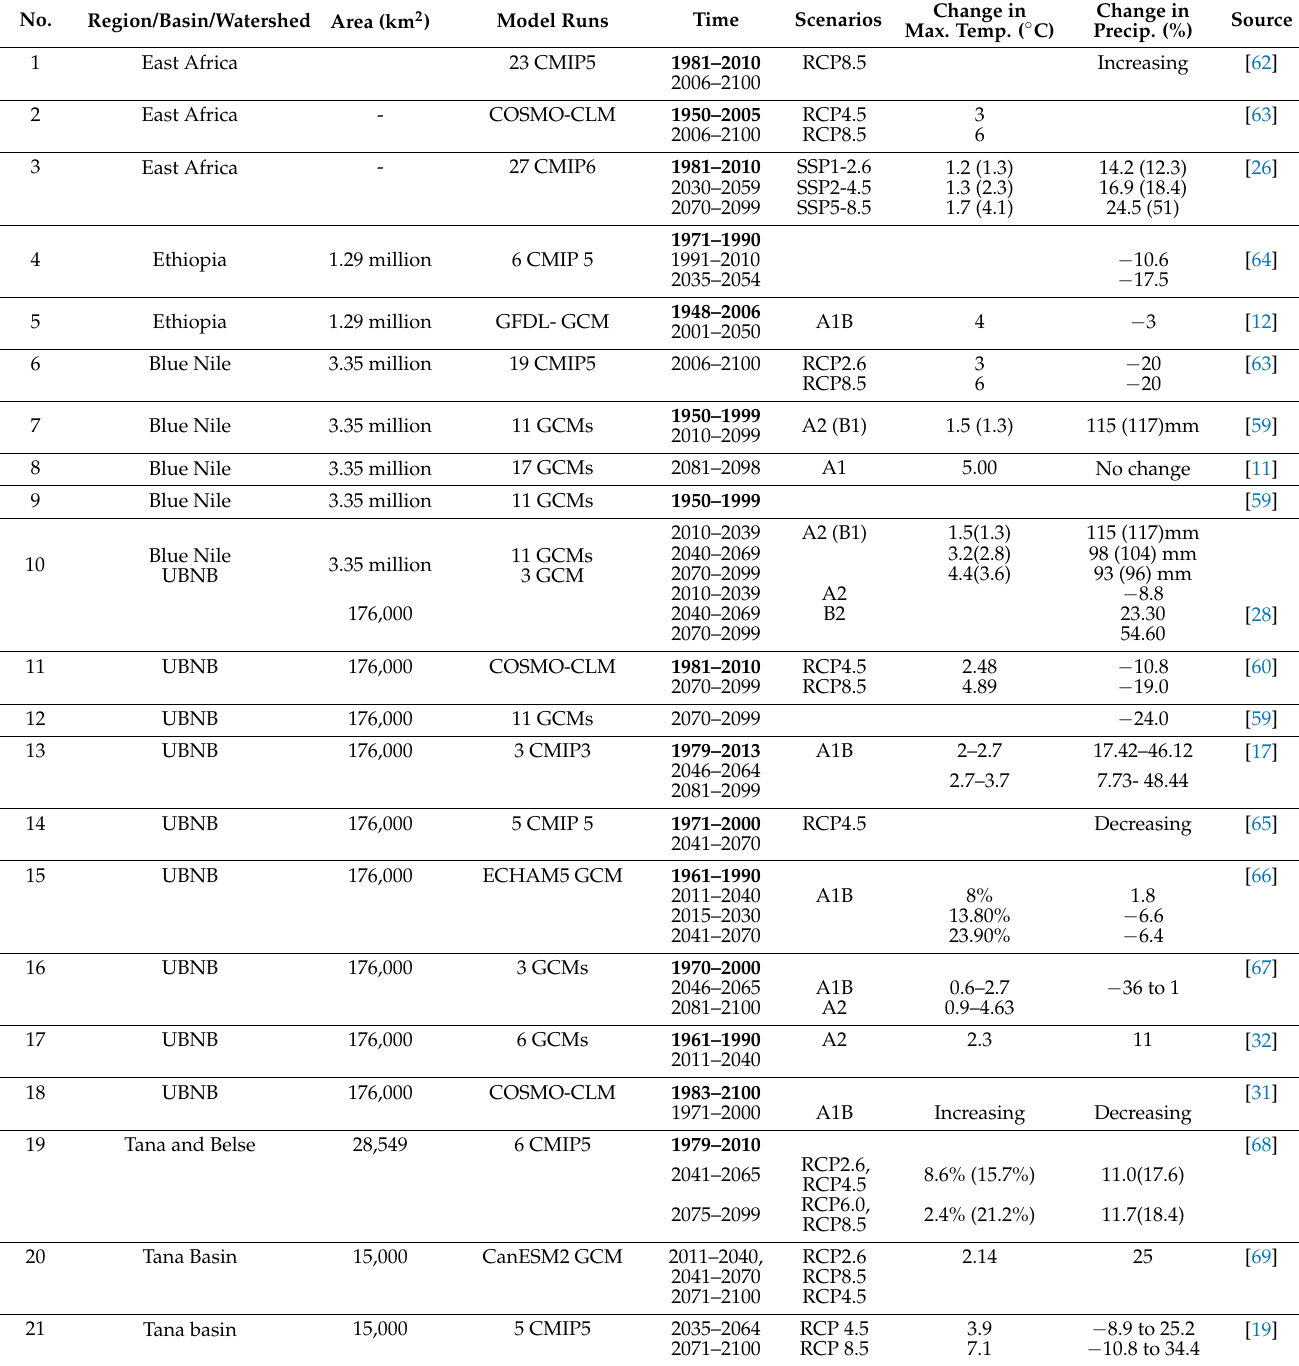
Table 5. Projected changes in temperature and precipitation by 21 previous studies in East Africa, Ethiopia, and UBNB ( Abay